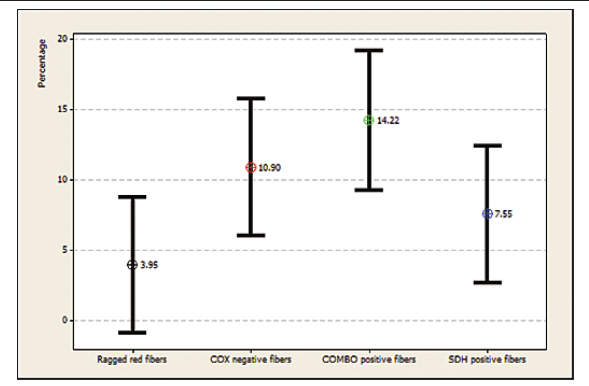
figurE 2 − Bonferroni comparison (95%) among the four quantitative events from 18 muscle biopsies with mitochondrial abnormalities taBLE 4 − Non-quantitative findings on muscle biopsy from 18 cases with mitochondrial abnormalities Variable